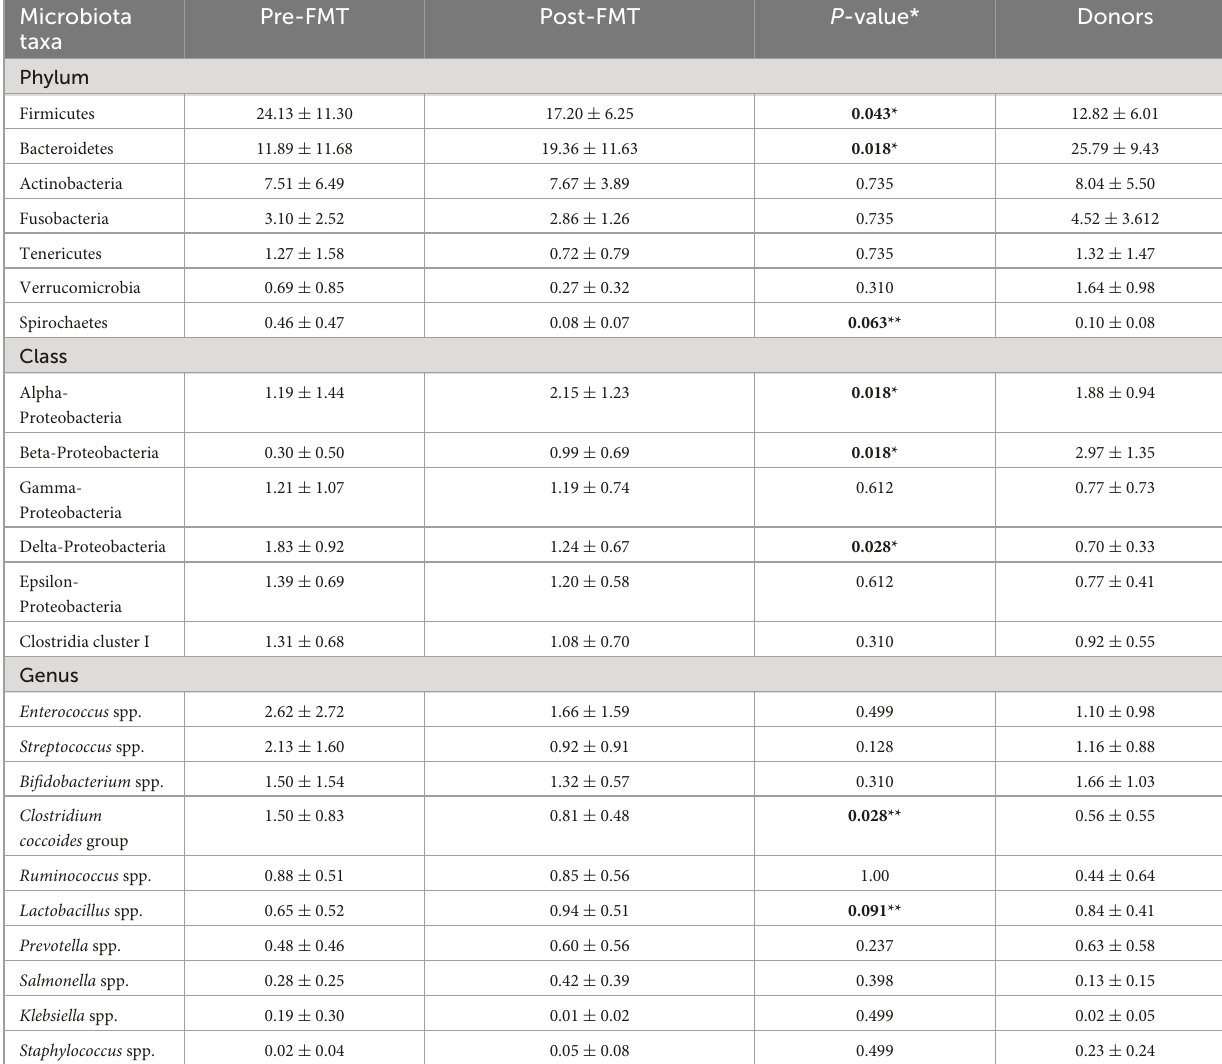
TABLE 2 Relative abundance of the bacterial taxa (at the phylum, class, and genus level) srudied in this